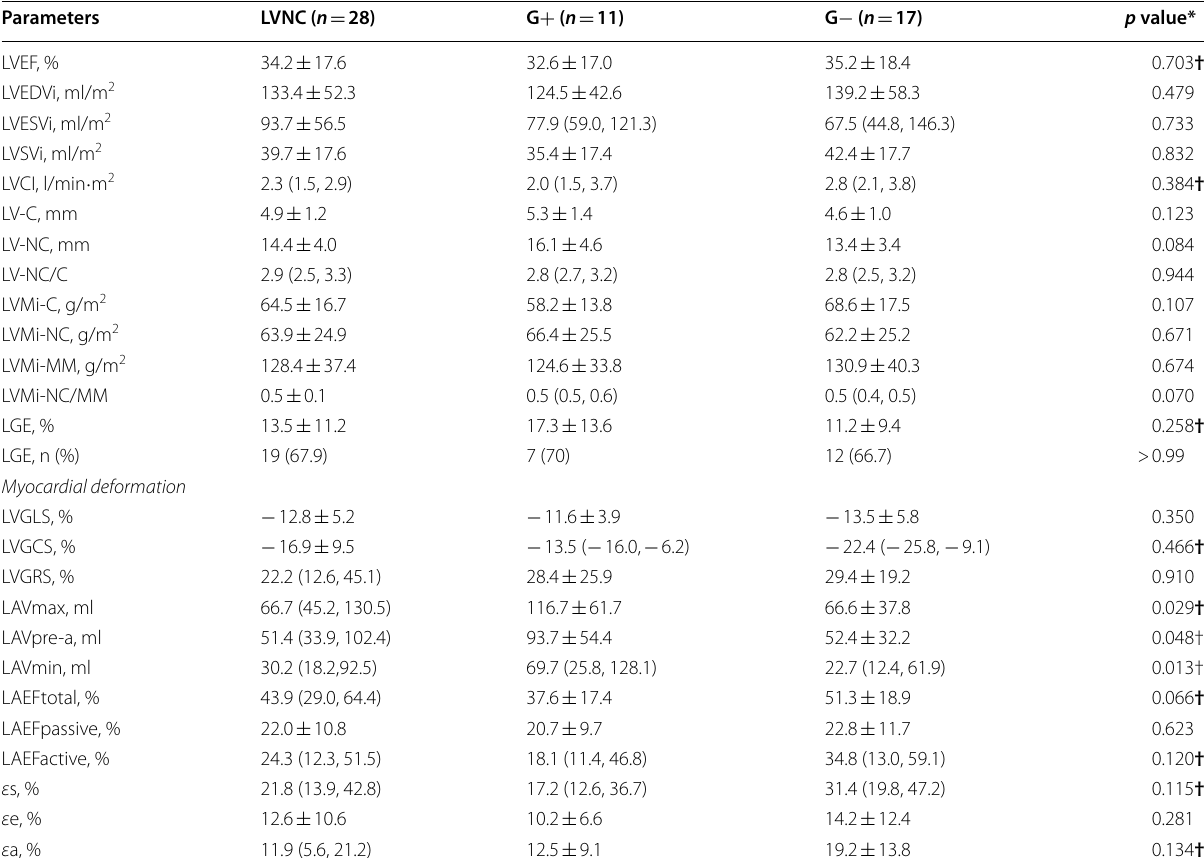
Table 2 Cardiac magnetic resonance data